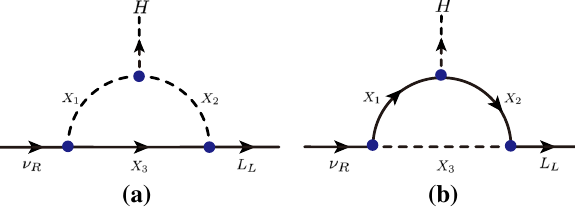
Fig. 9 One-loop realizations of the Dirac neutrino mass operator L 4 . The dashed line represents either a scalar or a vector field, while the solid line a fermion